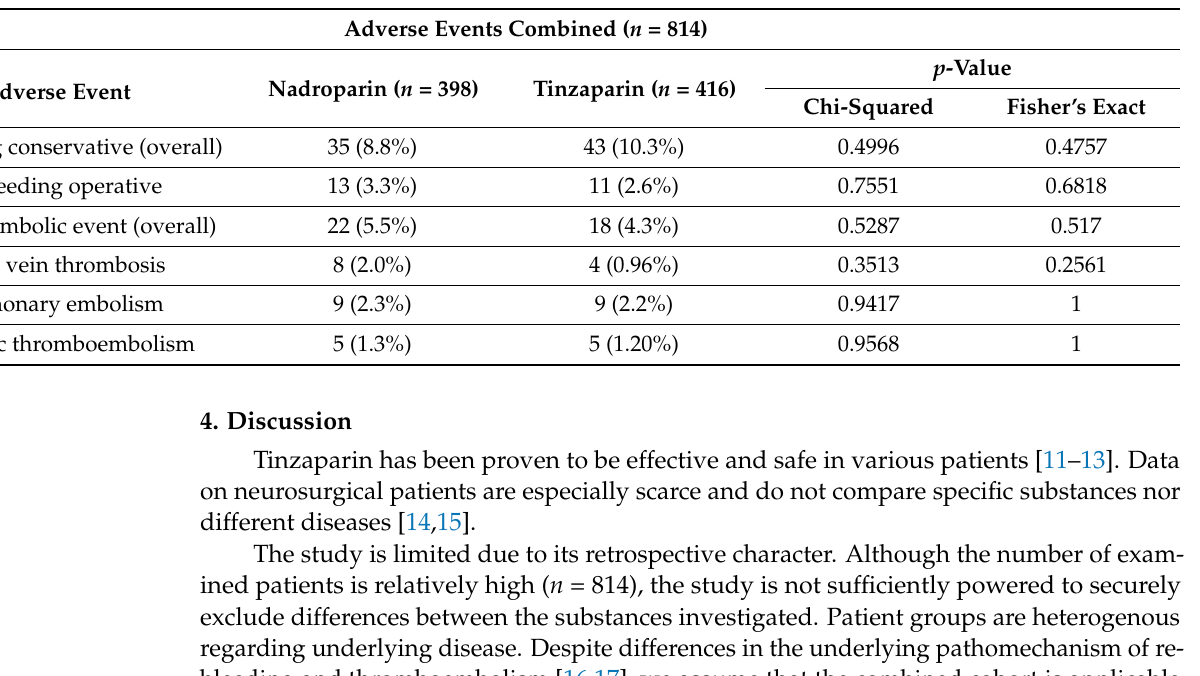
Table 2. Adverse events of the entire cohort treated with prophylactic nadroparin or tinzaparin. Eight hundred and fourteen patients received prophylactic